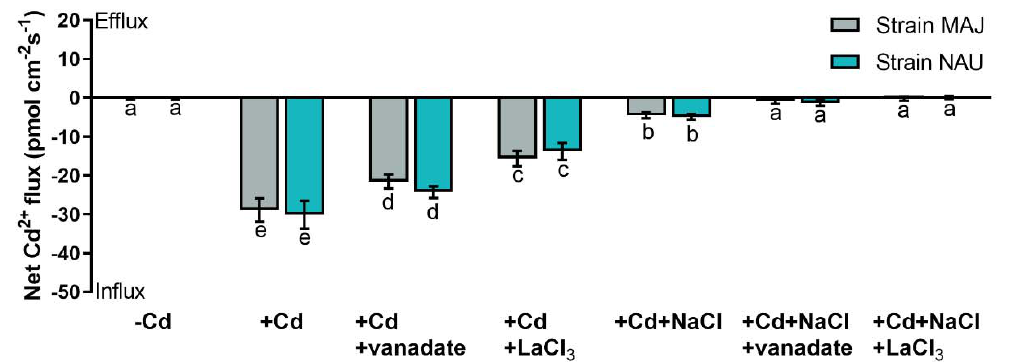
Figure 3. Net Cd 2+ fluxes in fungal hyphae of Paxillus involutus isolates (MAJ and NAU) under cadmium, salt, and inhibitor treatments. MAJ and NAU mycelia (the youngest and active hyphae) were hydroponically acclimated and subjected to 24 h of CdCl 2 (0 or 50 μ M) in combination with NaCl (0 or 100 mM). The short-term Cd- and Cd + NaCl-stressed fungal mycelia were treated with an inhibitor of plasmalemma H + -ATPase (sodium orthovanadate, 0 or 500 μ M) or an inhibitor of Ca 2+ -permeable channels (LaCl 3 , 0 or 5 mM) for 30 min. Following 30 min equilibration in measuring solutions, Cd 2+ flux recordings were continued for 15 min on the surface of pelleted hyphae. Mean values of Cd 2+ fluxes in control ( − Cd), CdCl 2 stress (+Cd), and combined stress of CdCl 2 and NaCl (+Cd + NaCl) in the presence and absence of inhibitors are shown. Cd 2+ flux was not detectable in salt controls that were treated without CdCl 2 . Each column is mean ± SD obtained from 5 fungal cultures. Statistically significant differences ( p < 0.05) among treatments are indicated with different letters